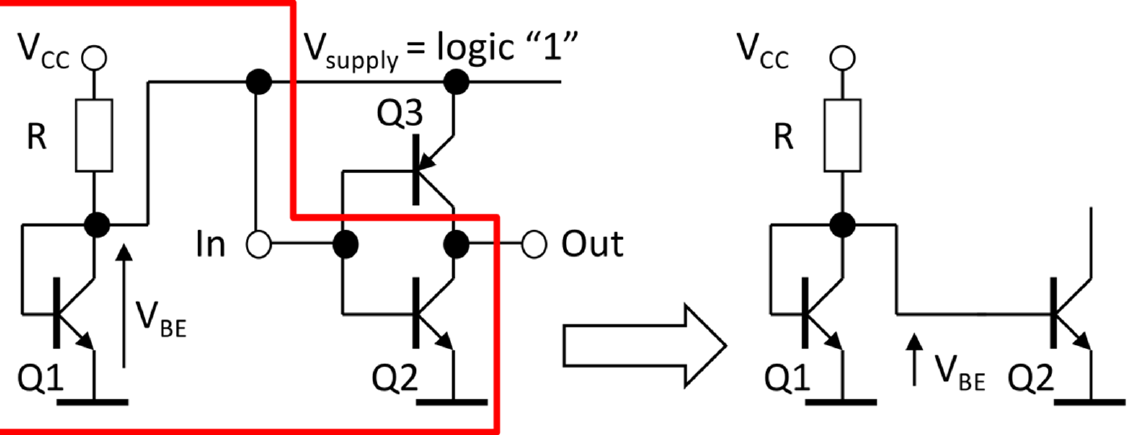
Figure 7. The concept of thermal stabilization of CBip gates: with “1” at the input of the inverter Q1 and Q2 make the current mirror.